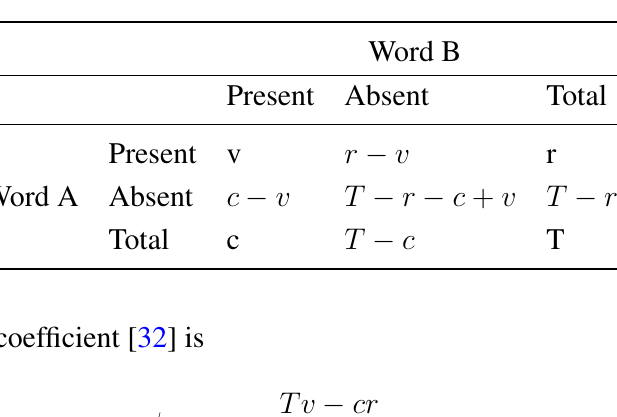
Table 1. Per cell calculation of the phi